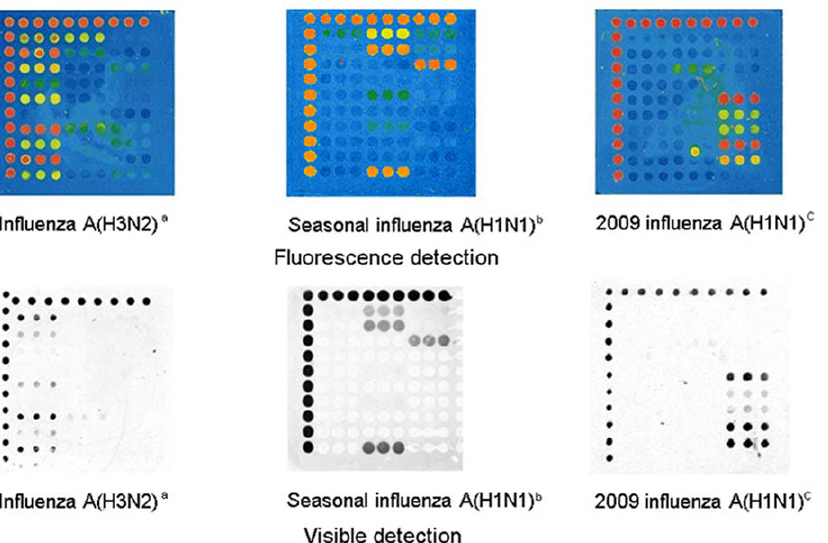
Figure 2. Fluorescence and visible detection of three subtypes of influenza A virus. a b c All of the three viruses used for comparing the accuracy between fluorescence and visible detection were clinical throat swab